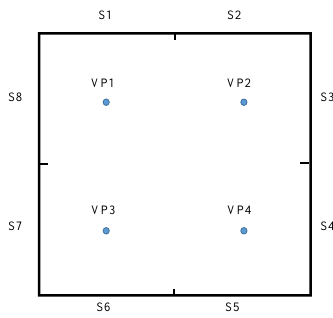
Figure 6. Example of the scanning